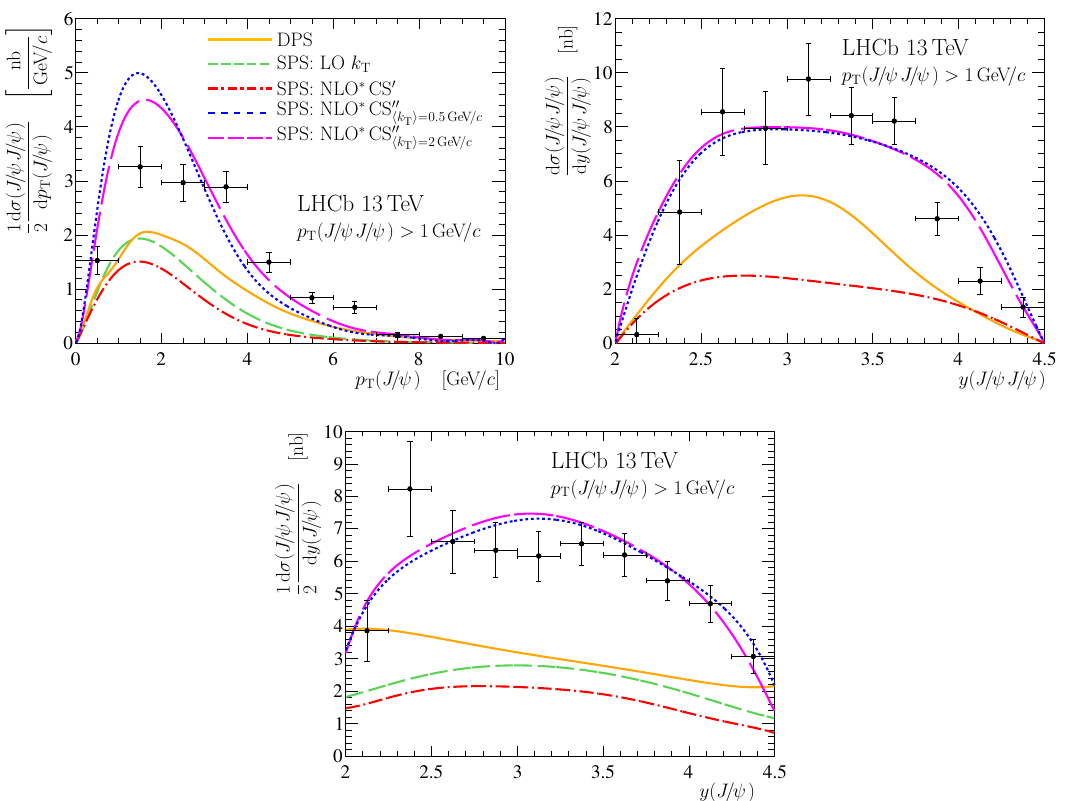
Figure 5. Comparisons between measurements and theoretical predictions with p T ( J= J= ) > 1 GeV =c for the di(cid:11)erential cross-sections as functions of (top left) p T ( J= ), (top right) y ( J= J= ) and (bottom) y ( J= ). The (black) points with error bars represent the